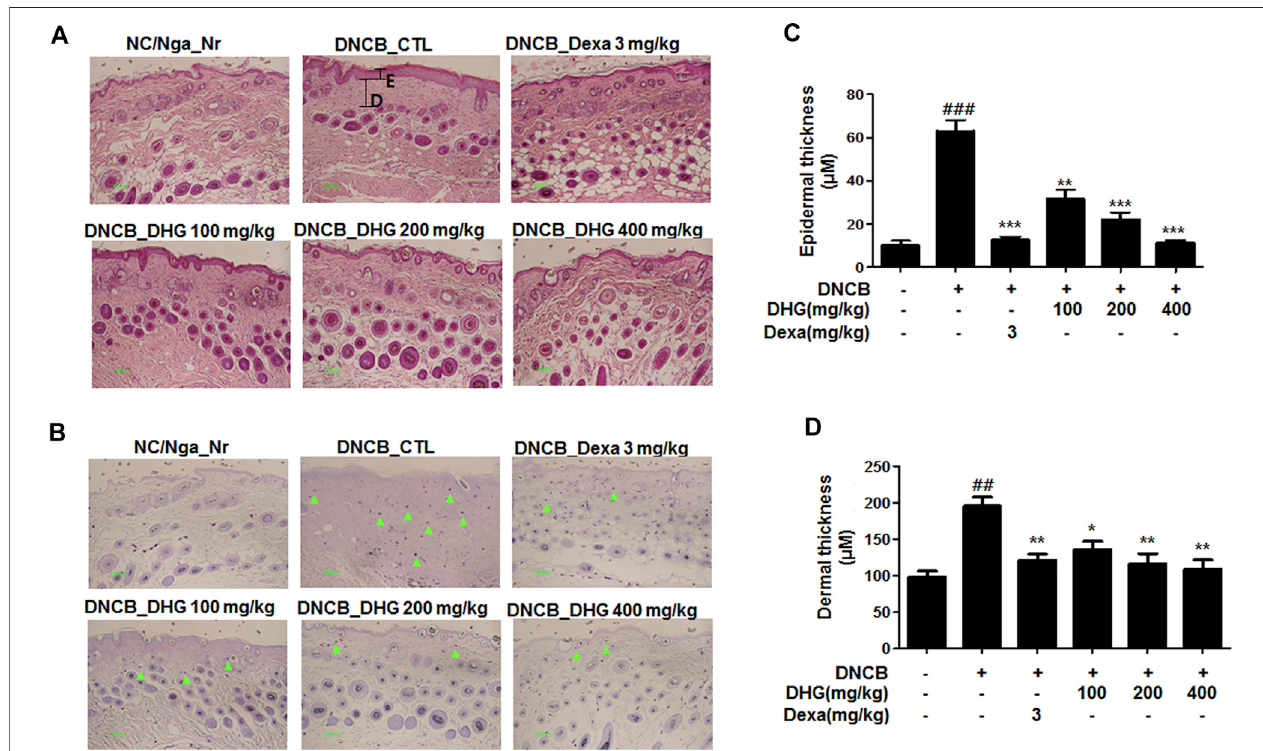
FIGURE 6 | Histological features of dorsal skin tissue in NC/Nga mice (total n = 6/group). Skin biopsy were dyed with H and E (A) and showed the change of the epidermis by bright microscope (x200). Skin biopsy were dyed with toluidine blue (B) and exposed the degranulated mast cells by bright microscope (x200) Epidermal and dermal thickness (C, D) were measured in HE stained section (Black line).